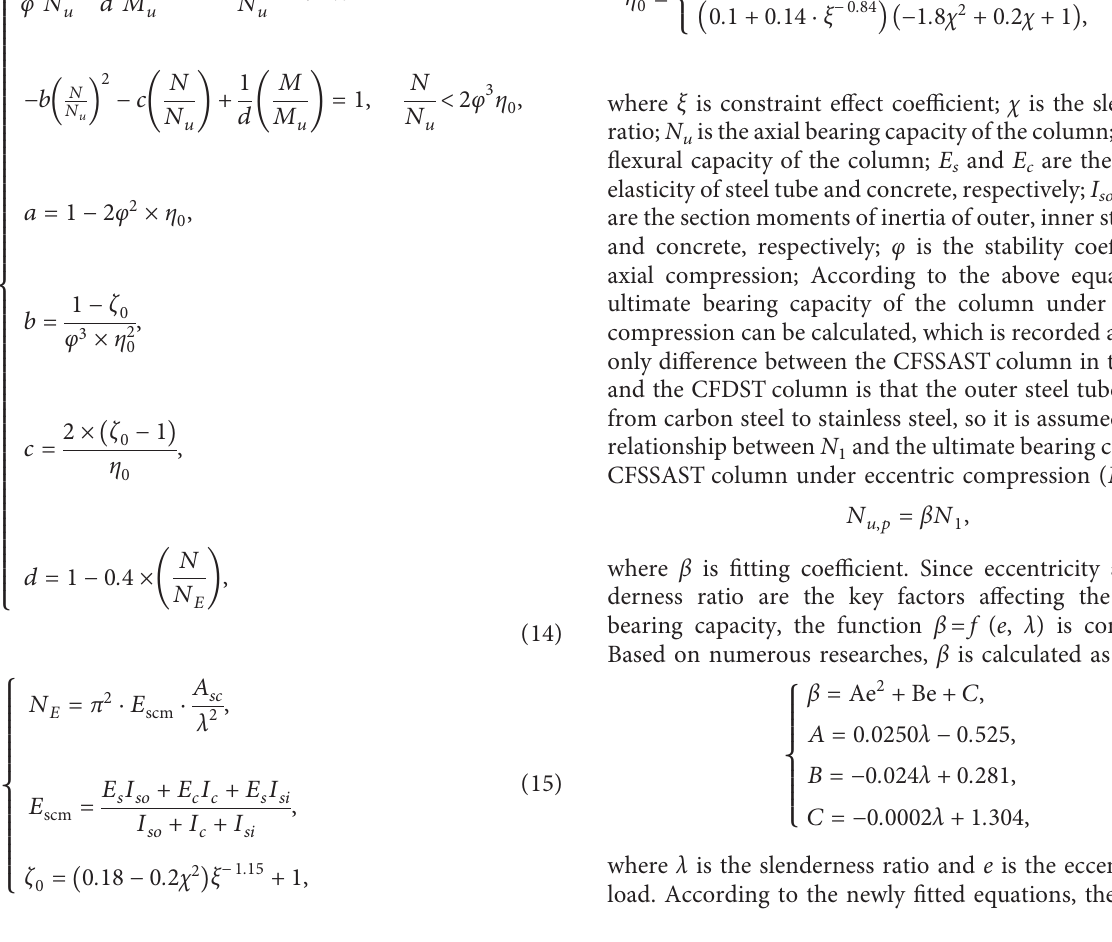
− Middle point deflection of the columns curves under different hollow ratio. (b) E